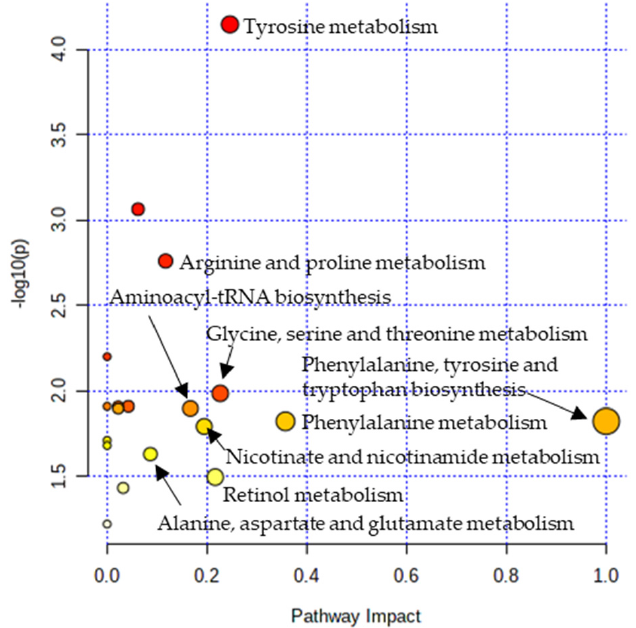
Figure 3. Pathway analysis showing significantly altered pathways in the CTE group. X-axis represents the pathway impact value from pathway topology analysis. Y-axis represents the − log10 ( p ) value from the enrichment analysis. The impact value is indicated by the size of the node and the significance of the pathway is indicated by the color of the node from yellow to red.